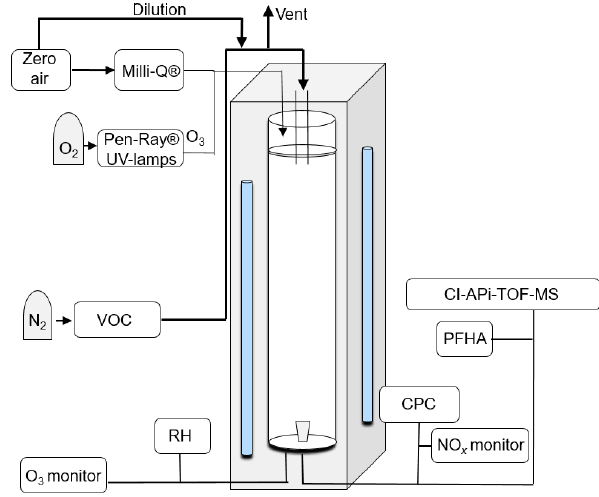
Figure 1. Schematic of the experimental setup with the Go:PAM chamber connected to the